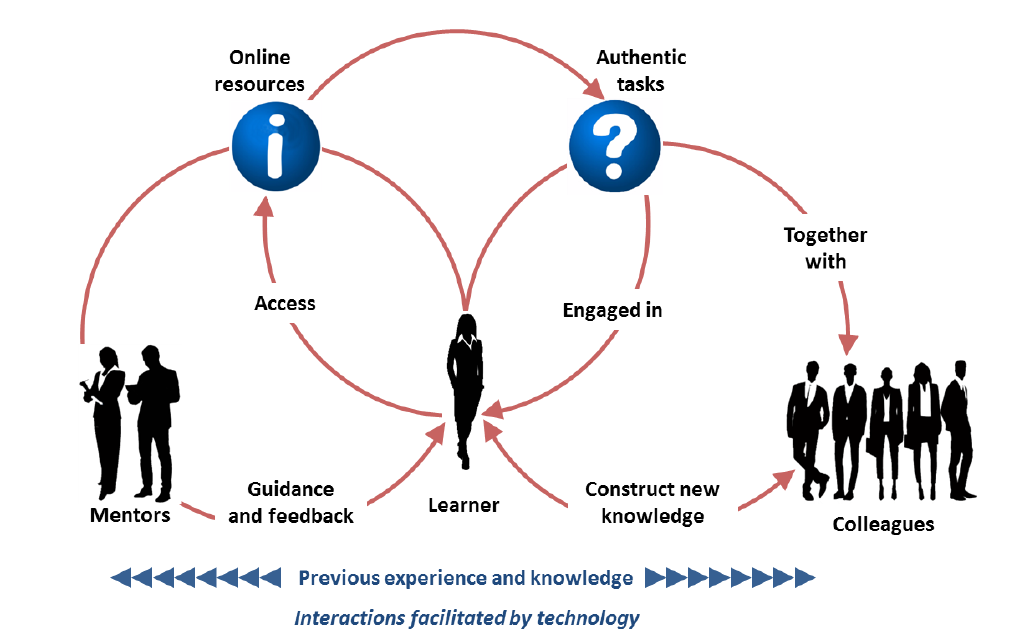
Figure 2. A framework of professional learning in authentic learning based